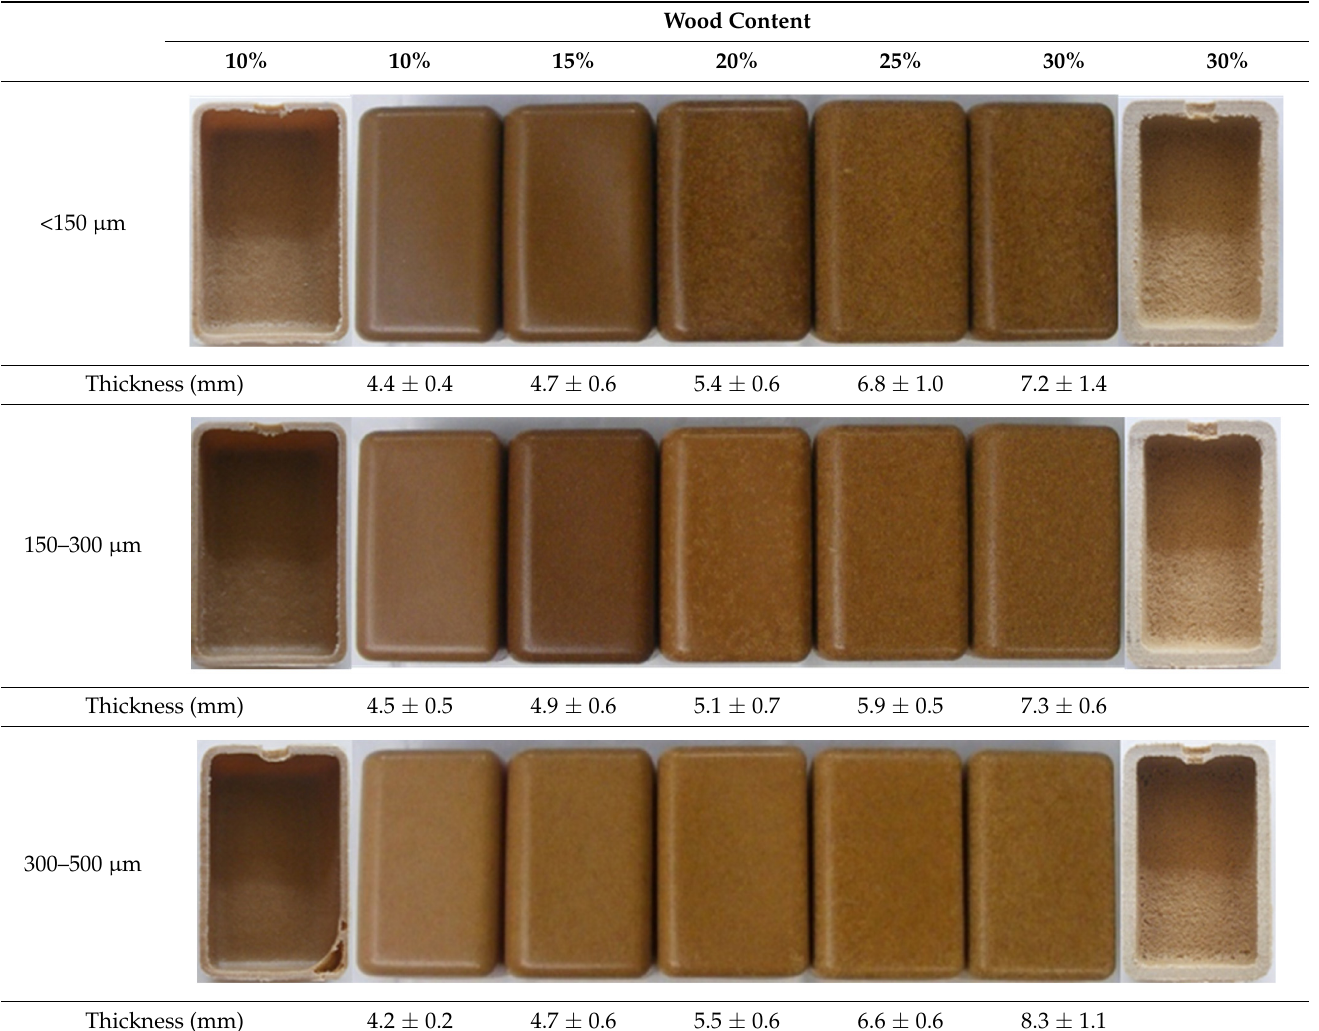
Table 5. Images of parts produced by MDPE/wood composites with 10, 15, 20, 25 and 30% wood